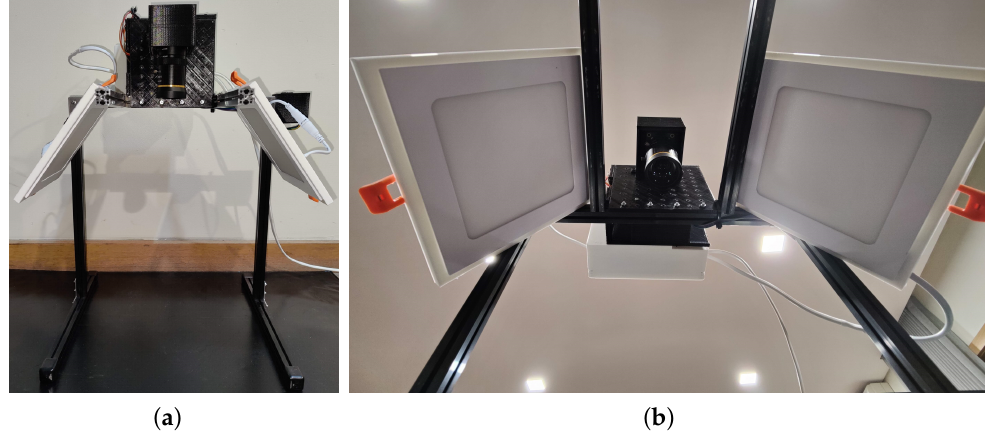
Figure 3. Developed system structure: ( a ) Frontal view; ( b ) Bottom-up